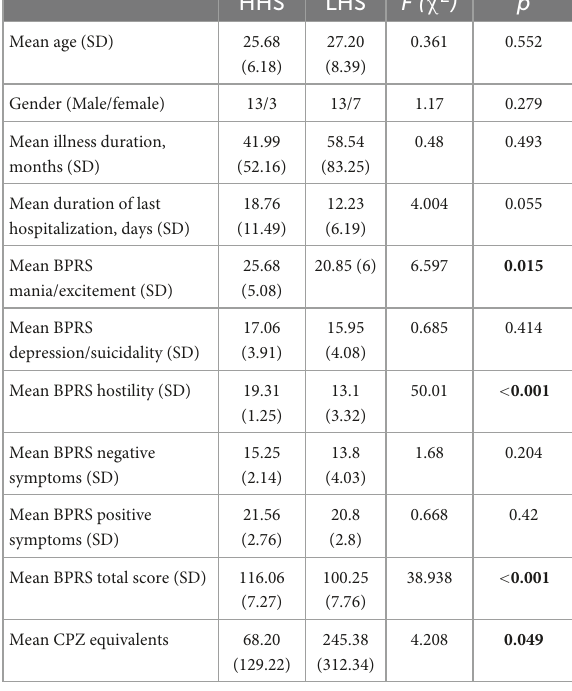
TABLE 1 Sociodemographic and clinical characteristics of clinical